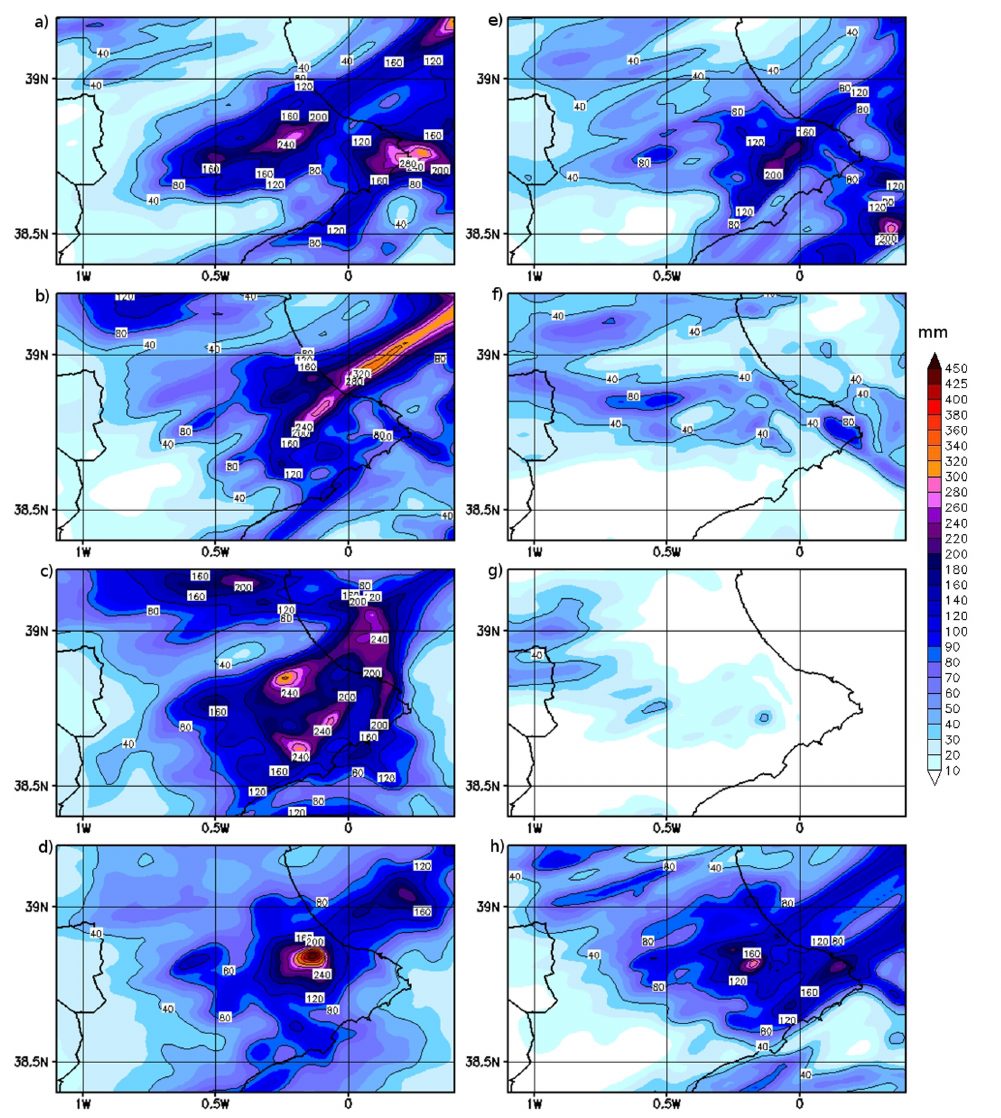
Fig. 8. RAMS Grid 4 48-h accumulated precipitation forecast in mm for the whole event: (a) Kuo1, (b) Kuo2, (c) Kuo 3, (d) Kuo4, (e) KF1, (f) KF2, (g) KF3 and (h)